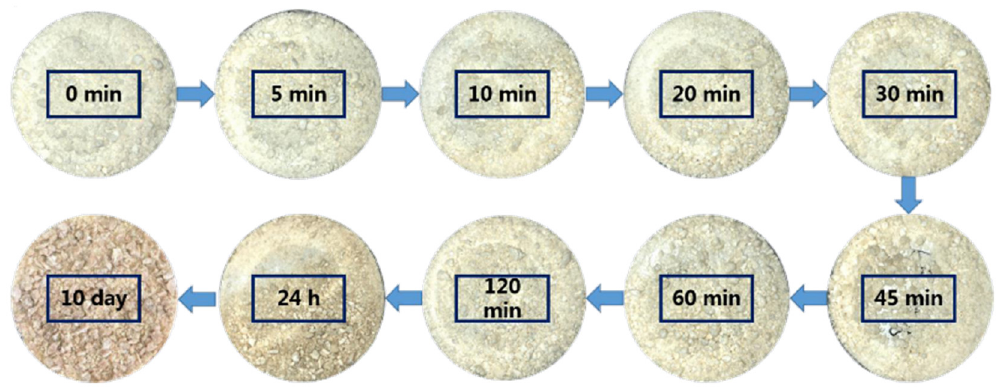
Figure 11: E ff ect of di ff erent residence times on the colour of HBSA powder.